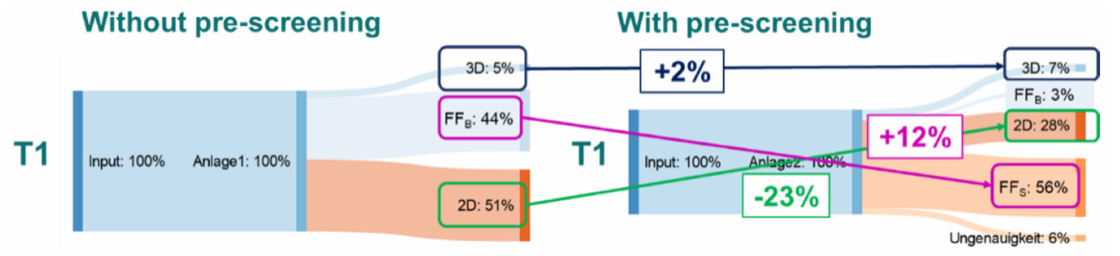
Figure 12. Mass balance for test run 1 with mixed commercial waste